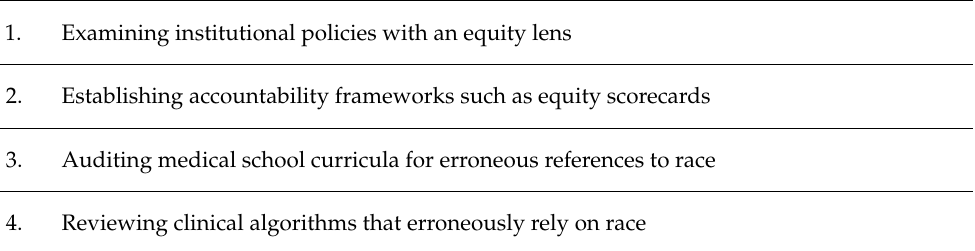
Table 6. Strategies for combatting systemic racism in healthcare